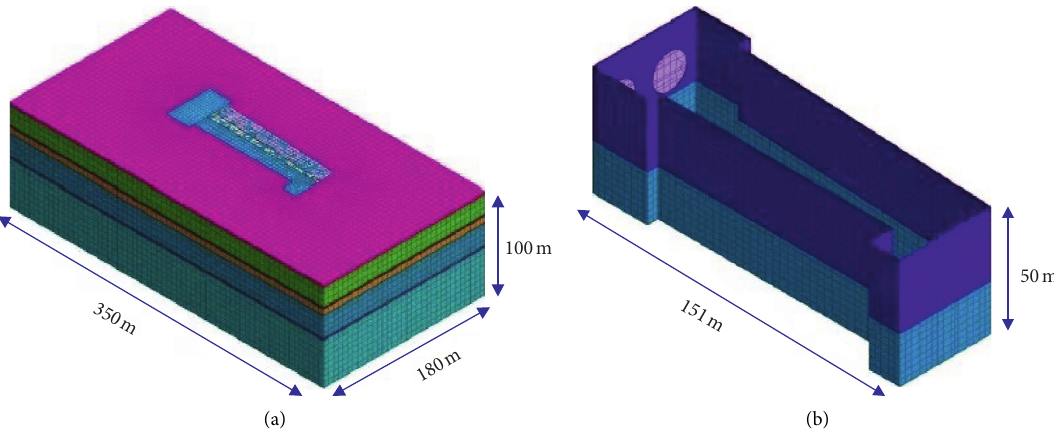
Figure 10: Numerical simulation model. (a) Calculation model. (b) Continuous wall structure.